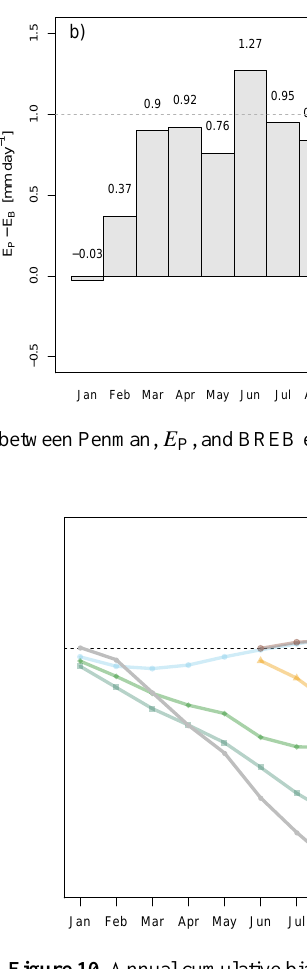
Figure 10. Annual cumulative bias on evaporation estimate (BREB minus Penman) for the 6 lakes.